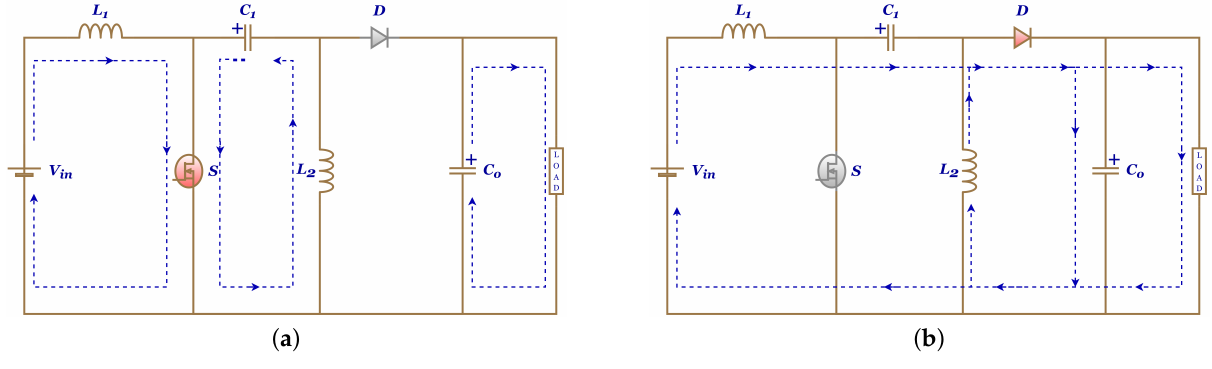
Figure 21. SEPIC operation: ( a ) S closed, and ( b ) S open.